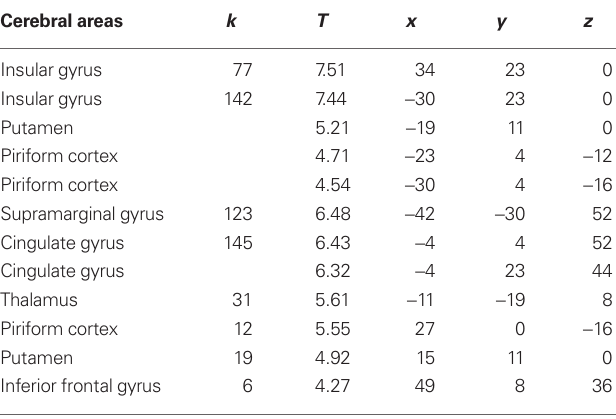
Table 2 | Conjunction analysis between the four categories of response (Hit, Miss, CR, and FA) and the two groups (young and elderly) of